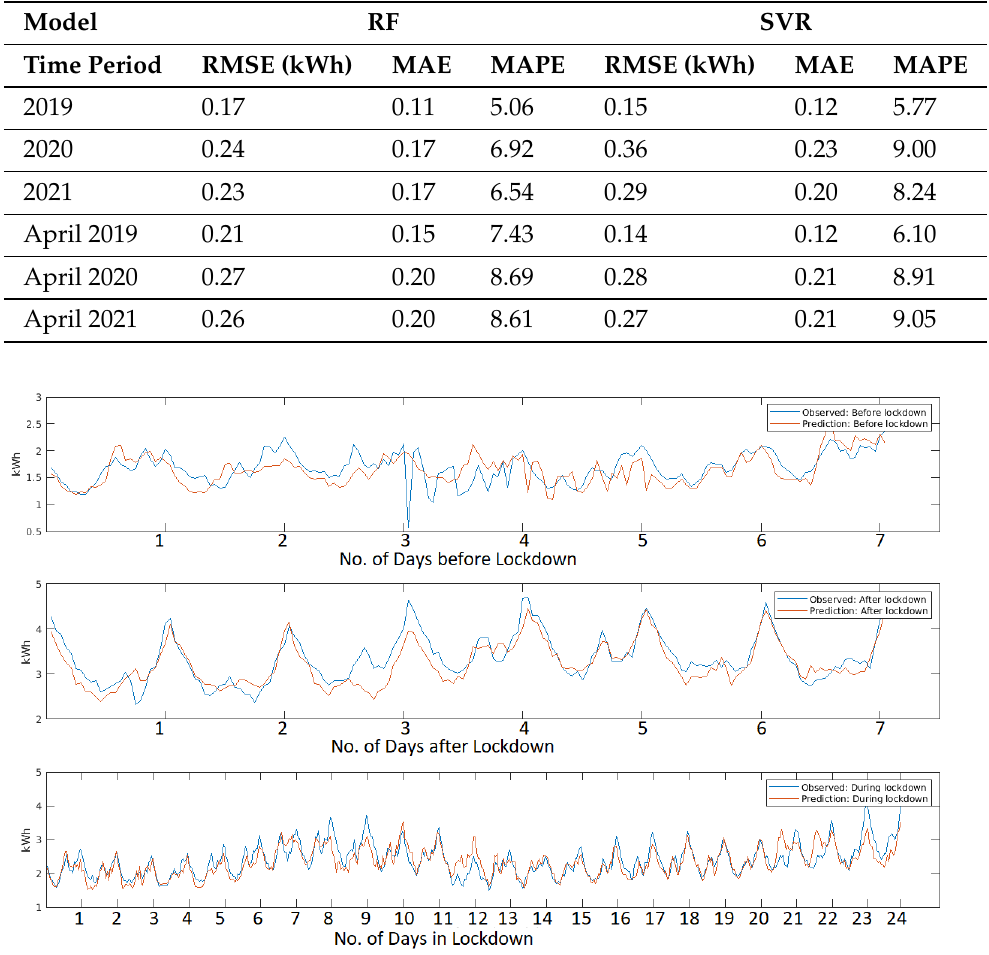
Figure 19. Day-ahead prediction for the week before, after, and during the